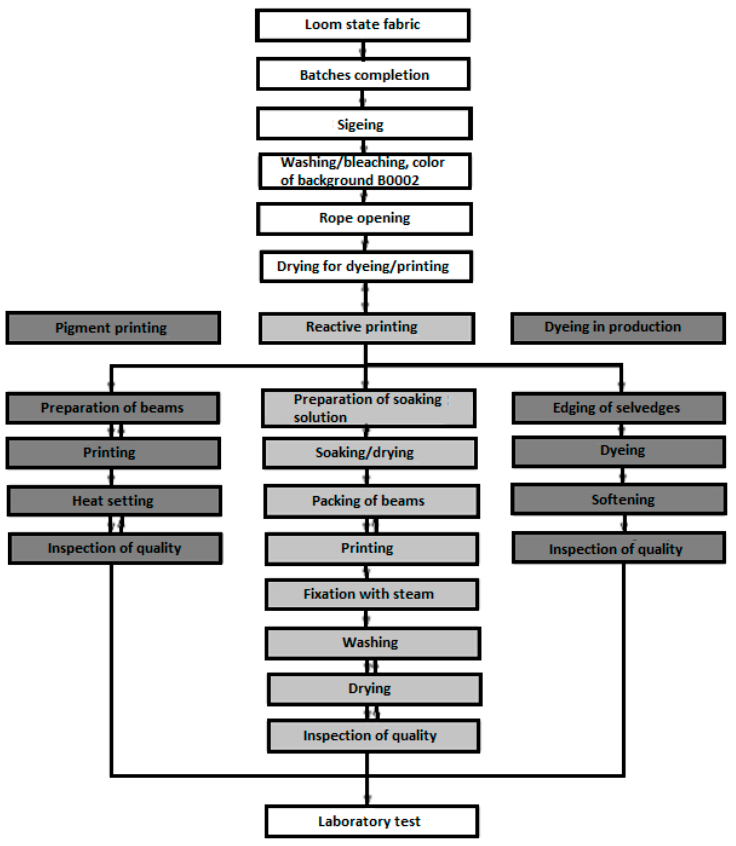
Figure 2. Technological processes of the researched linen/silk cloth